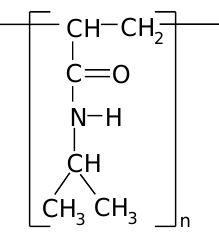
Figure 1. Chemical structure of the repeating unit of poly( N -isopropylacrylamide) (PNIPA).